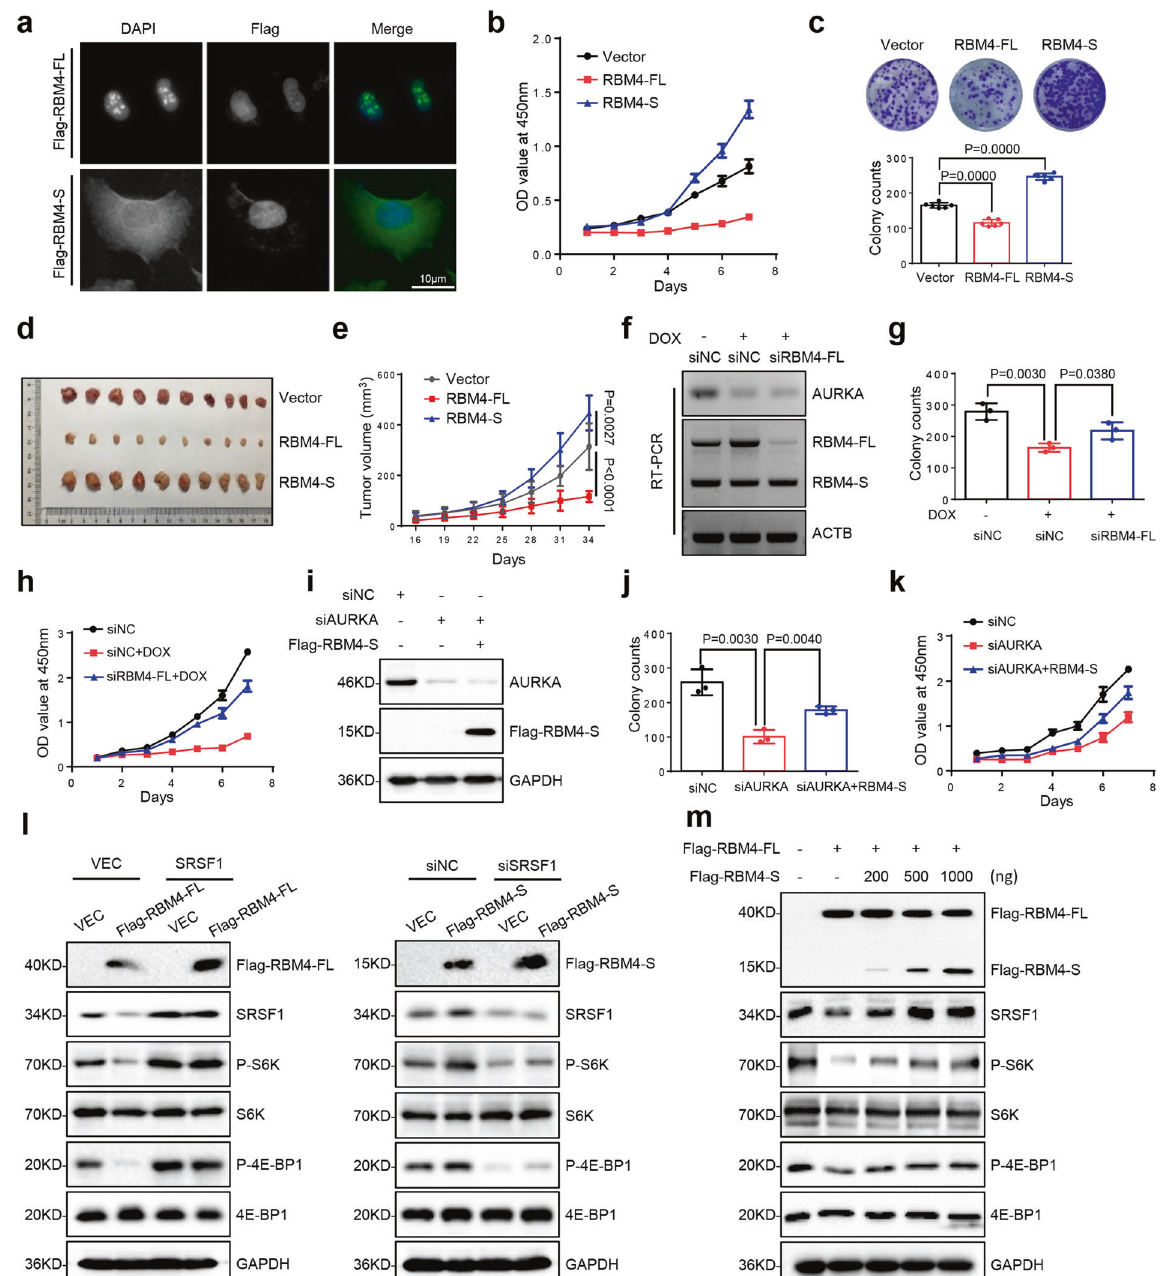
Fig. 2 RBM4-S functions as a tumor promoter by abolishing RBM4-FL-mediated inhibition of SRSF1-mTORC1 activity. a Flag-labeled RBM4-FL and RBM4-S were transfected into A549 cells, respectively. The localization of Flag-RBM4-FL and Flag-RBM4-S was detected by IF assay with anti-Flag antibody (green). The nuclei were stained with DAPI (blue). Scale bar, 10 μ m. The effects of RBM4-FL and RBM4-S on the proliferation of A549 cells. Cells were stably transfected with Vector, RBM4-FL, RBM4-S plasmids, and the proliferative ability of cells was analyzed by b cell counting kit-8 (CCK8) and c colony formation assays. d , e Immunode fi cient mice were subcutaneously inoculated with equal number of Vector, RBM4-FL, and RBM4-S stably expressing A549 cells (2 × 10 6 cells per mouse, n = 10). Photograph and tumor volume were shown. f Validation of the expression of AURKA and two variants of RBM4 by RT-PCR. g , h Colony formation and CCK8 proliferative assays were conducted to examine cell proliferation ability. i Validation of the expression of AURKA and exogenous Flag-RBM4-S by western blot. j , k Colony formation and CCK8 proliferative assays were performed to examine cell proliferation ability. l SRSF1 was transiently expressed in control and Flag-RBM4-FL overexpressed A549 cells, and SRSF1 was transiently depleted in control and Flag-RBM4-S overexpressed A549 cells. The protein expression levels of Flag-RBM4-FL or Flag-RBM4-S, SRSF1, P-4E-BP1, 4E-BP1, P-S6K, and S6K were assessed by western blot assay and normalized to GAPDH. m Increasing amounts of Flag-RBM4-S were co-expressed with Flag-RBM4-FL in HEK-293T cells. Flag-RBM4-FL/S, SRSF1, P-4E-BP1, 4E-BP1, P-S6K, and S6K protein expression levels were assessed by western blot and normalized to GAPDH. Data are shown as means ± SD. P -values were calculated with two-tailed unpaired Student ’ s t -test and P < 0.05 is considered statistically signi fi cant